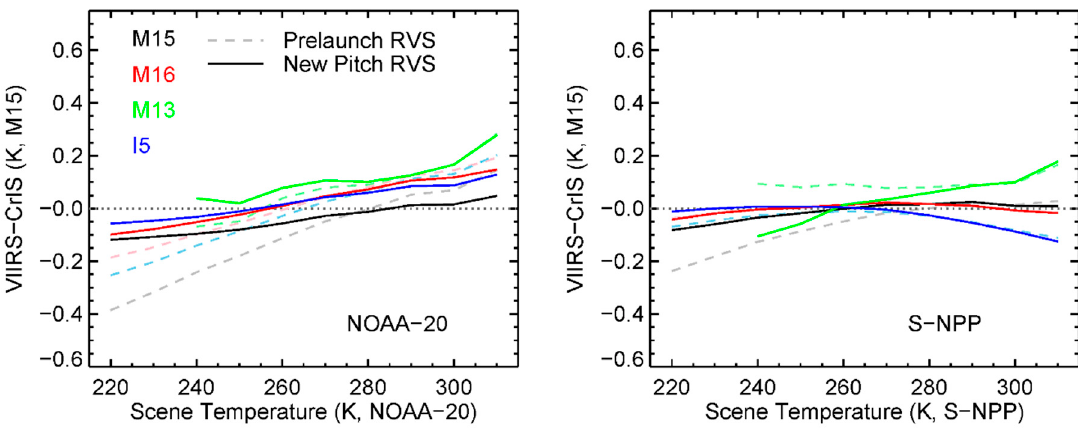
Figure 13. NOAA-20 VIIRS–CrIS BT differences as function of CrIS scene temperature. Scene temperature dependent biases for the reprocessed VIIRS SDRs (the Wang et al. method derived on-orbit RVS) were plotted in the foreground in solid lines; biases for the NOAA operational processing (prelaunch RVS) were plotted in the background using dash lines and pale colors.